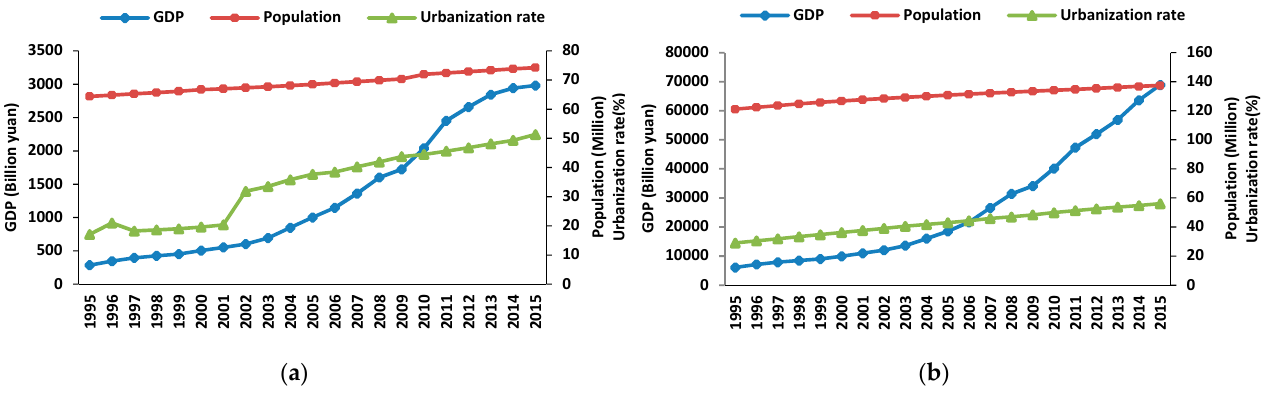
Figure 1. The trends of GDP, population, and urbanization rate in Hebei Province ( a ) and China ( b ) from 1995 to 2015.